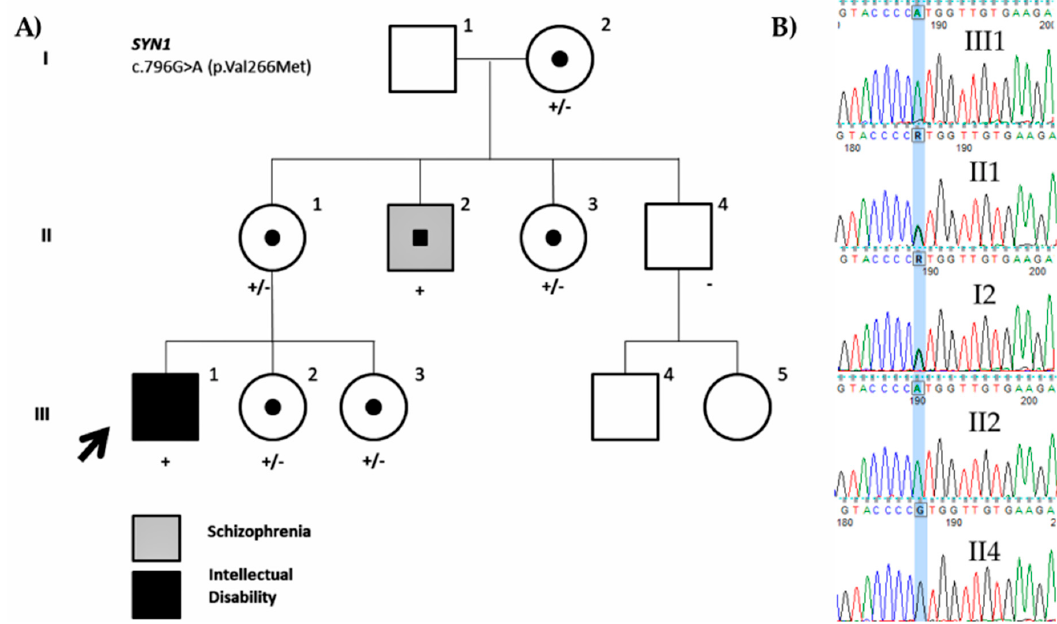
Figure 6. Family pedigree of the ID1402 proband. ( A ) Segregation of the missense variant in SYN1 (NM_006950.3: c.796G>A; p.Val266Met) is shown. The black color indicates intellectual disability and the grey indicates schizophrenia. ( B ) Partial DNA sequence of the SYN1 gene. The identified nucleotide change is highlighted.